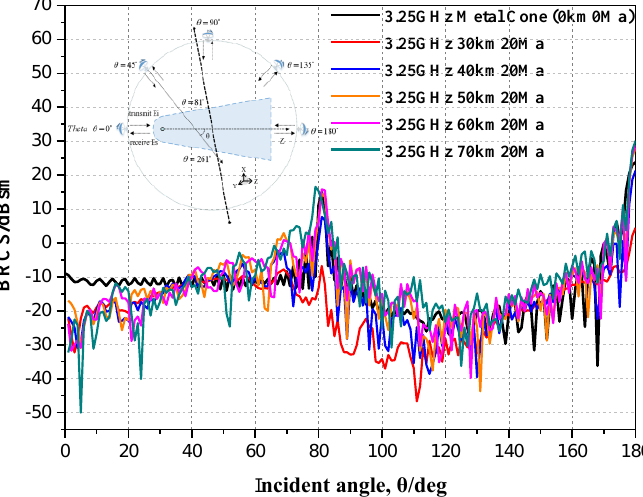
Figure 4. Variation of BRCS with flying altitude for hypersonic vehicle, when the incident wave frequency is 3.25 GHz and the velocity is 20 Mach.